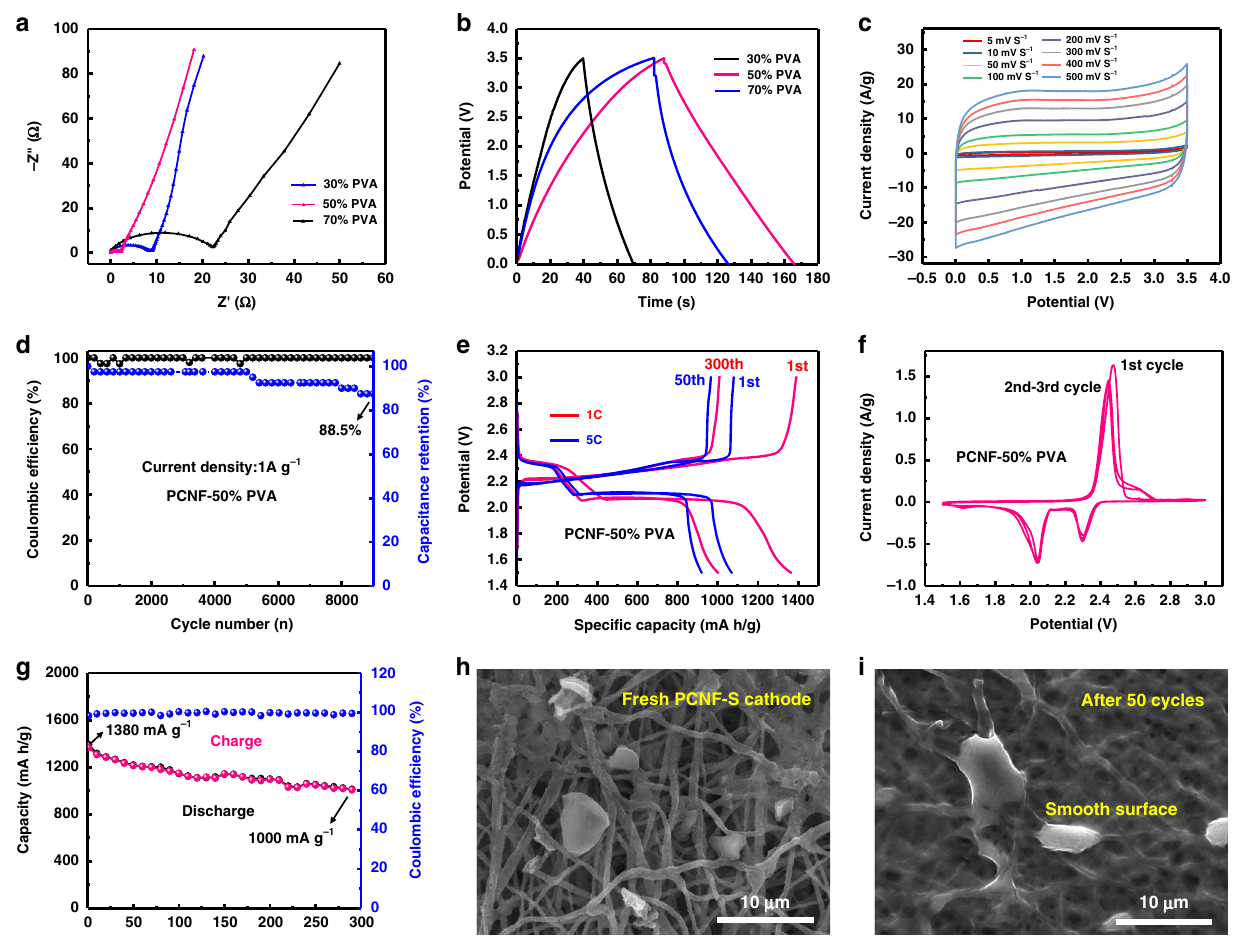
Fig. 4 Electrochemical performance of the PCNF fi lms. a – d The performance of the freestanding PCNF electrodes in supercapacitors with Li-ion electrolytes. a Impedance spectra of the PCNF electrodes before cycling. b CP curves at a current density of 1 A g − 1 . c CV curves of at four different scan rates. d Long cycling performance at 1 A g − 1 . e – i The performance of PCNF-S cathodes in Li-S batteries. e Galvanostatic voltage pro fi les at 1 C and 5 C. f Continuous CV curves at a scan rate of 0.1 mV s − 1 . g Long cycling performance at 1 C. h , i Surface morphology of the fresh electrode and the electrode after 50 cycles at 1 C, respectively. Source data are provided as a Source Data fi